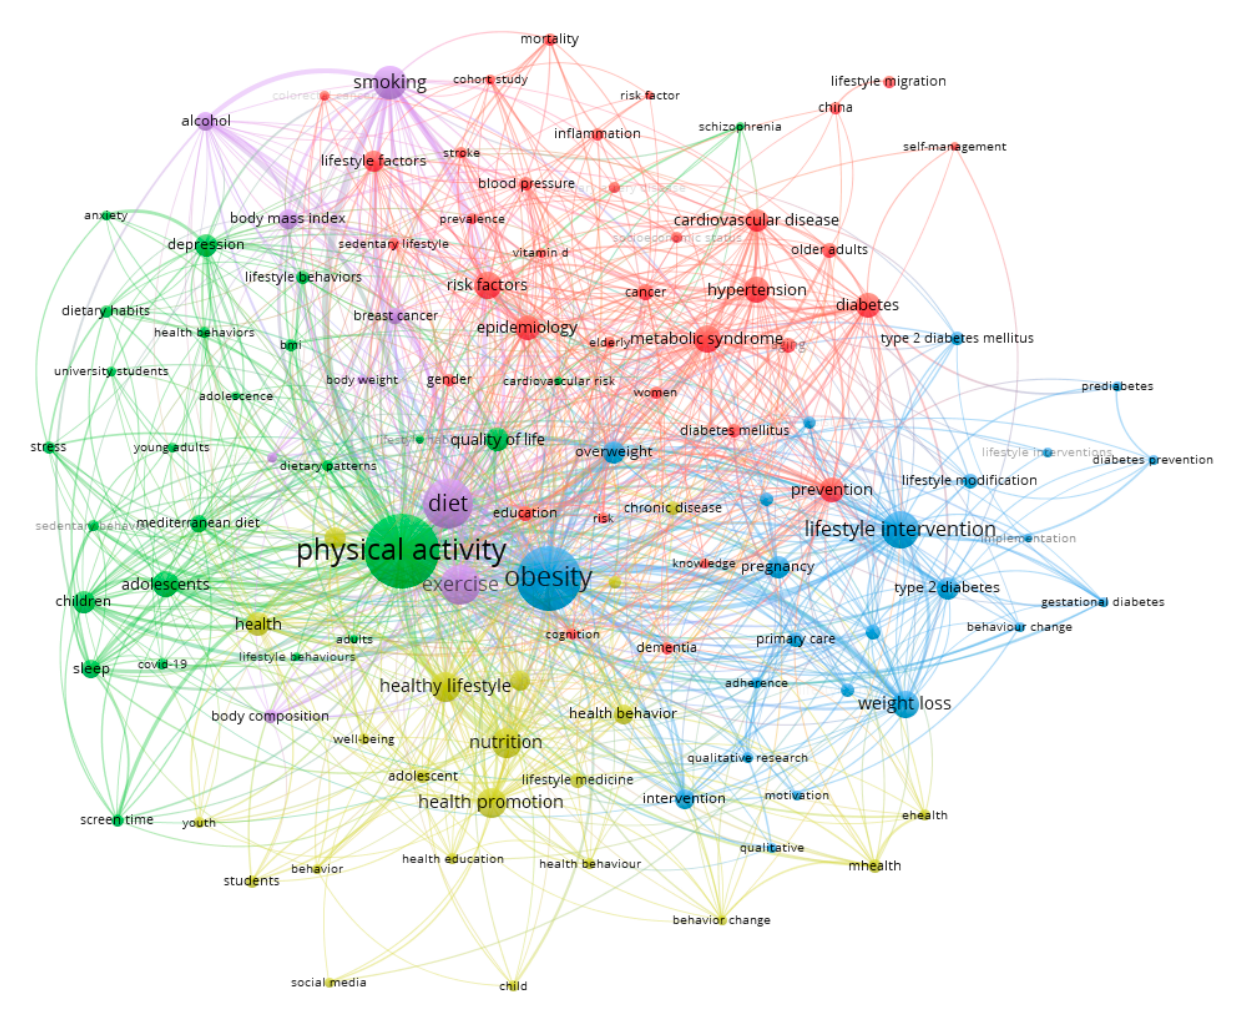
Figure 4. Co-occurrence analysis of top keywords.